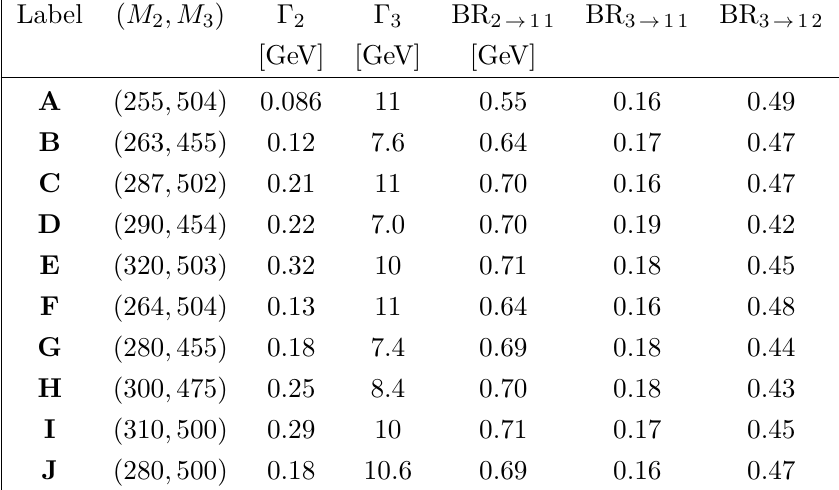
, we have M = 125 GeV and Γ = 3 . 8 MeV for all points 1 1 1 3 → h 2 h 2